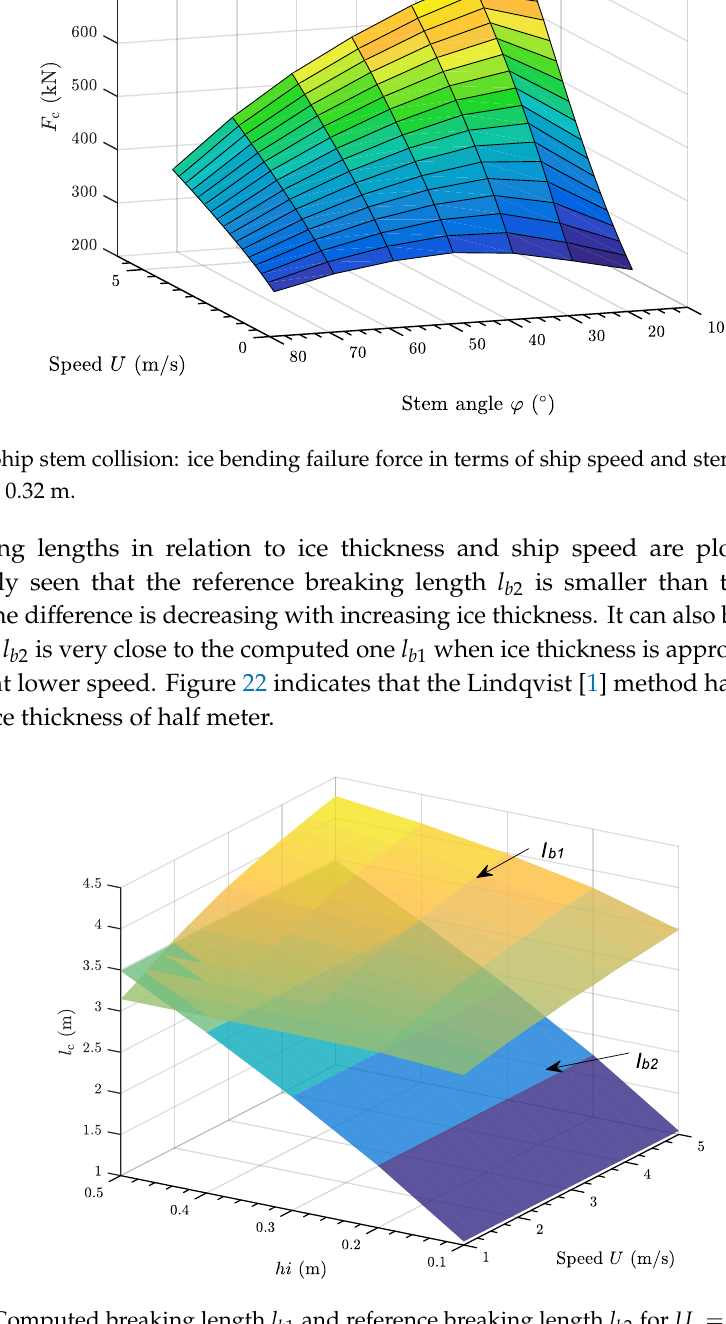
Figure 22. Computed breaking length 𝑙 𝑏1 and reference breaking length 𝑙 𝑏2 for 𝑈 = 3 m/s for bow collision scenario.